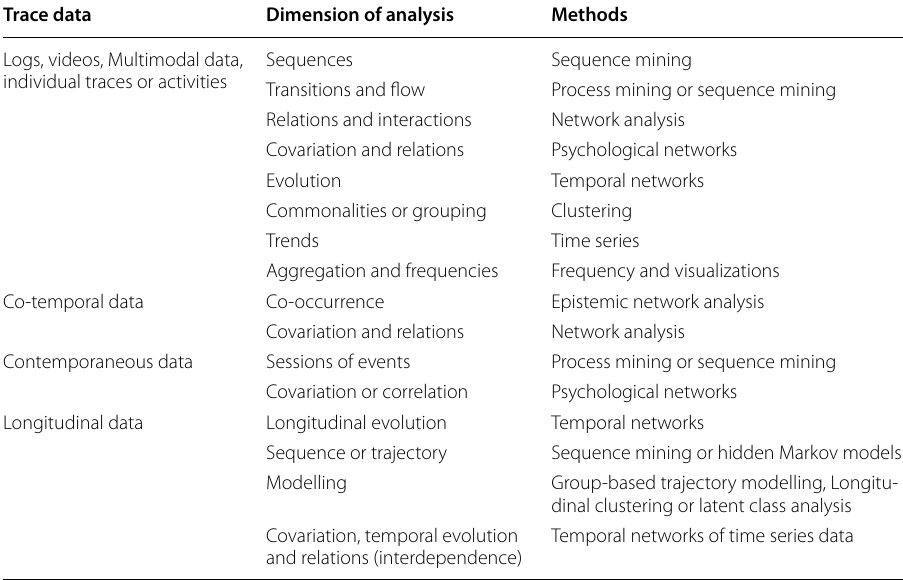
Table 1 Suggested methods for analysis based on trace data temporal